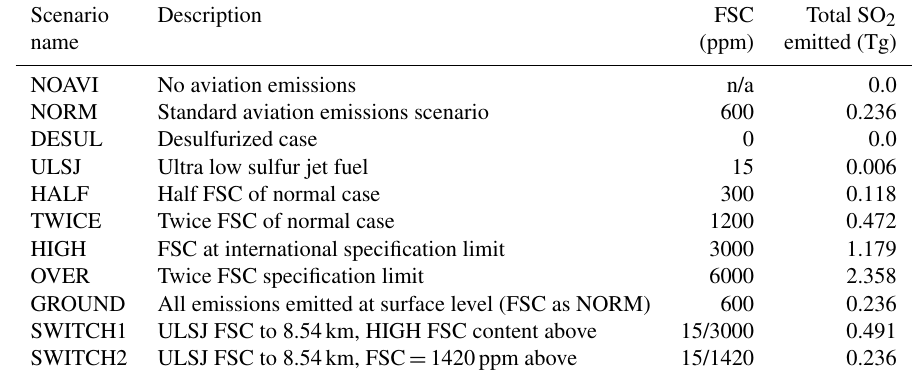
Table 2. FSC and global SO 2 emissions applied in each model experiment. Scenario Description FSC Total SO 2 name (ppm) emitted (Tg) NOAVI No aviation emissions n/a 0.0 NORM Standard aviation emissions scenario 600 0.236 DESUL Desulfurized case 0 ULSJ Ultra low sulfur jet fuel TWICE HIGH OVER Twice FSC specification limit GROUND All emissions emitted at surface level (FSC as NORM)